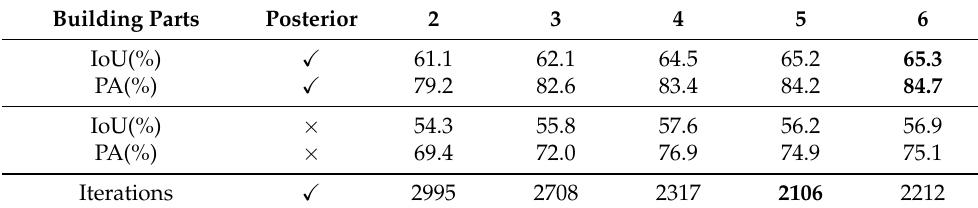
Table 1. Performance of different number of building parts on the test set.